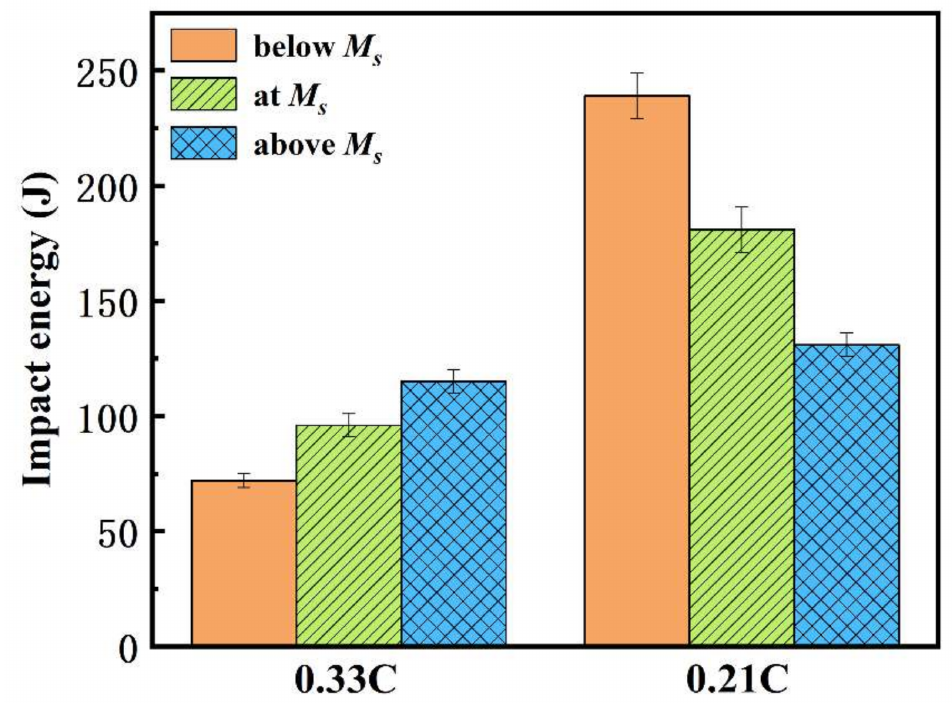
Figure 9. Impact energy of both steels at different heat treatment